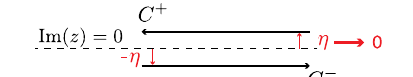
FIG. 6. Complex integration to Fourier transform the resolvent into the time domain. Complex contour to Fourier invert G ð z Þ to U ð t Þ , in the limit η → 0 . The dashed line in the middle represents the real axis Im ð z Þ ¼ 0